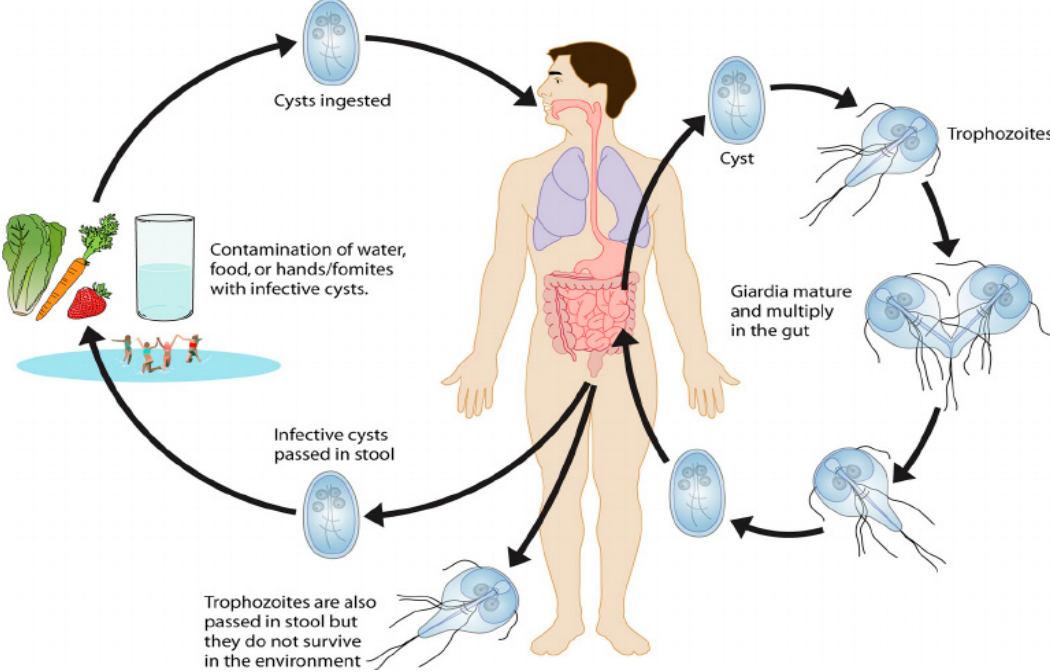
Figure 2. Life cycle of Giardia [24].